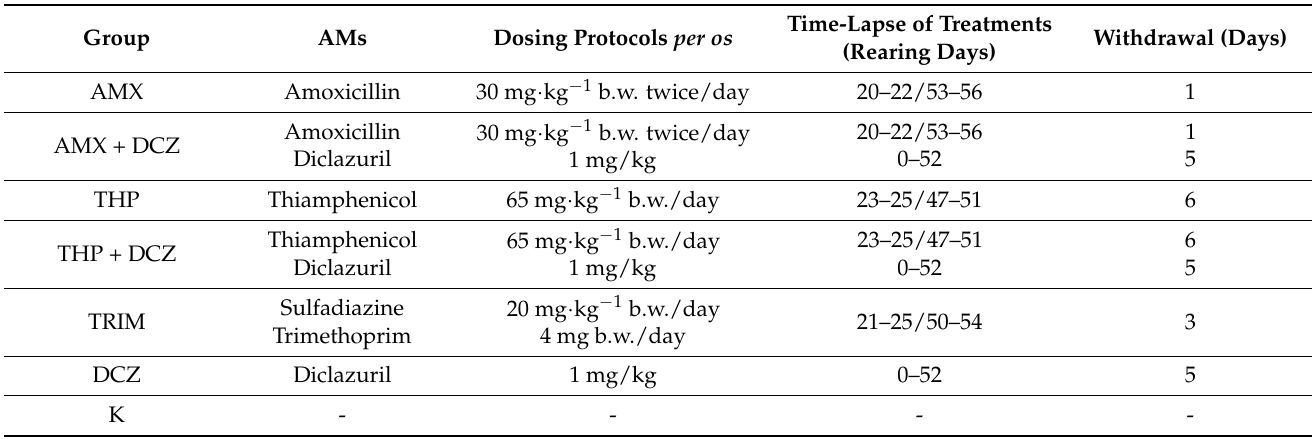
Table 2. Antimicrobial (AM) prophylactic treatment protocols applied during broiler rearing. The animals were divided into seven groups and slaughtered after a withdrawal